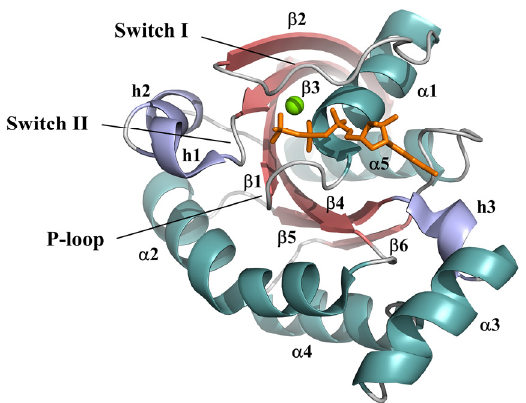
Figure 1. Crystal structure of GTP γ S-RhoA G14V (PDB ID: 1A2B) with β -strands (red), α -helices (teal), and 3 10 -helices (slate) differently colored and labeled. GTP- γ S—orange stick; Mg 2+ ion—green ball.